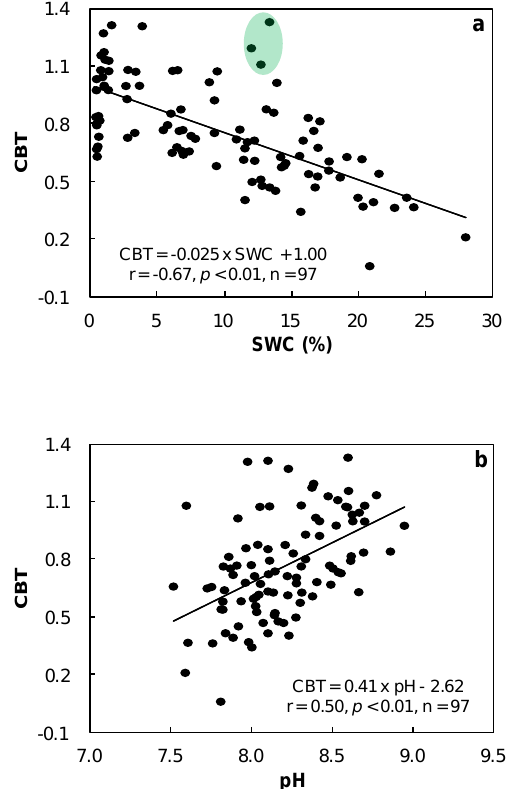
Figure 5. Linear regression plots of (a) CBT vs. SWC and (b) CBT vs. pH for 97 surface soils in this study. The light green shade in (a) indicates three Yongdeng soil samples collected immediately after a